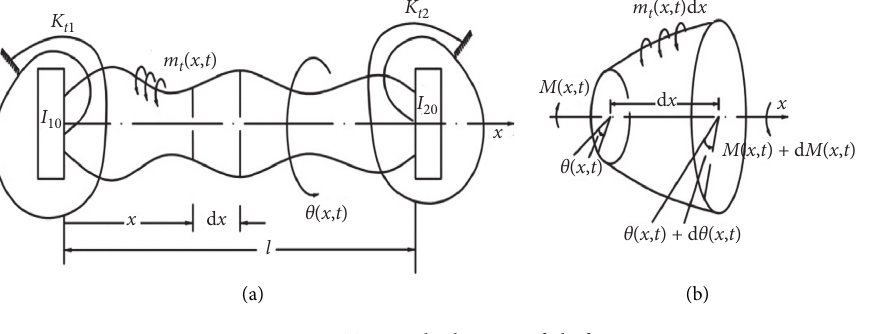
Figure 3: Torsional vibration of